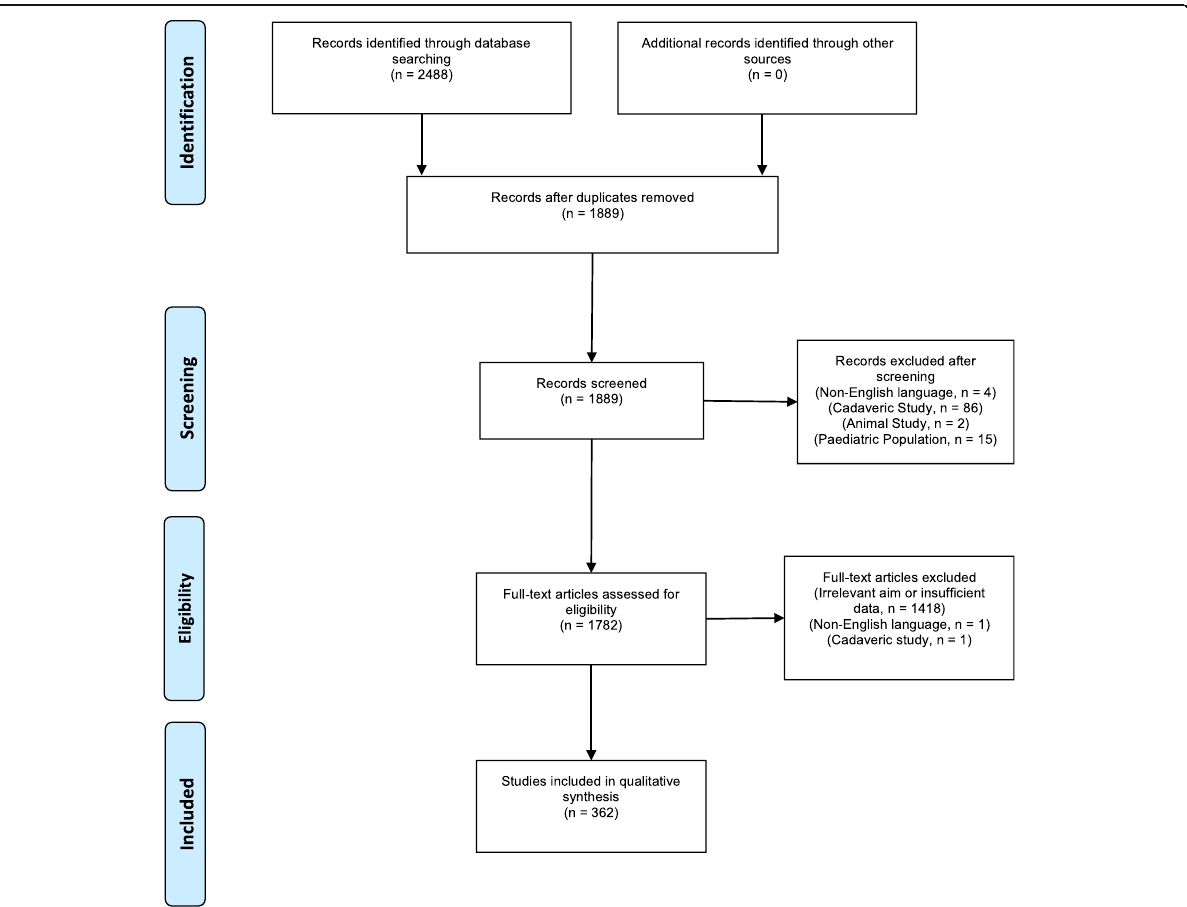
Fig. 1 Flow diagram of inclusion and exclusion (initial search May 24, 2016)